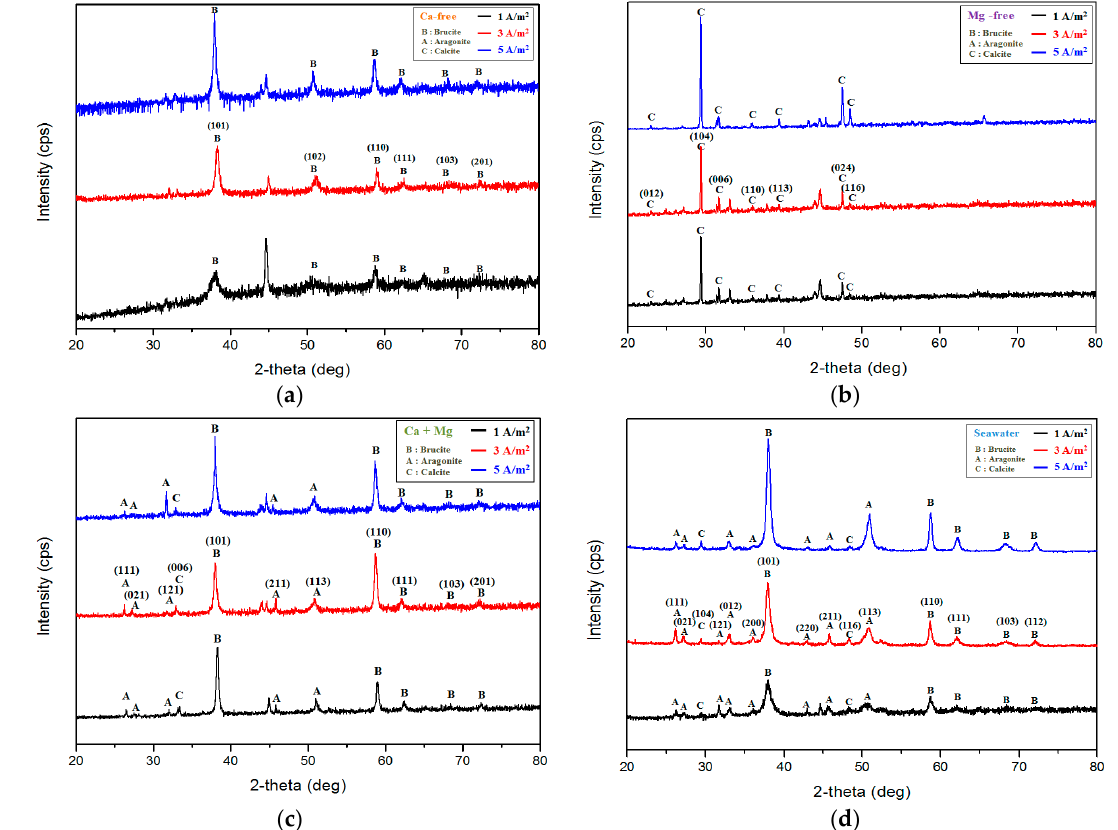
Figure 5. Crystal structure of the calcareous deposit films after 24 h in each solution ( a ) Ca-free, ( b ) Mg-free, ( c ) Ca + Mg, ( d ) natural seawater.